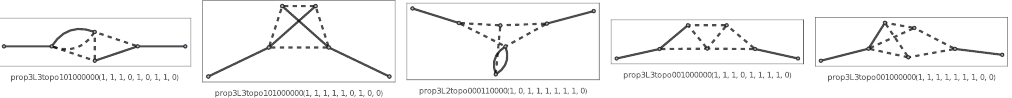
Figure 2: Some of the nonfactorizing on-shell 3-loop master integrals occurring in our matching calculation. A solid line denotes a massive propagator with m a dashed line corresponds to a massless